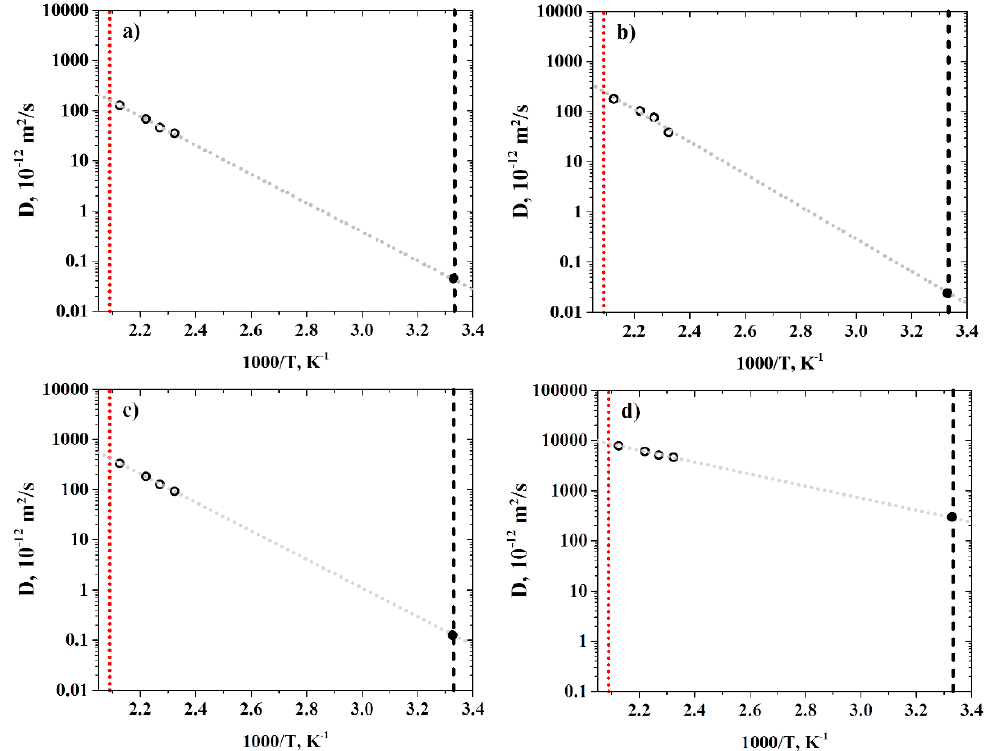
Figure 6. Dependence of the diffusion coefficients of ( a ) CH 4 , ( b ) N 2 , ( c ) O 2 , and ( d ) He in R-BAPB on the reciprocal temperature obtained in molecular dynamics simulations. Semi-logarithmic axes. The red dotted line indicates the glass transition temperature of R-BAPB. The black dashed line corresponds to T = 300 K. The solid black symbols indicate the diffusion coefficients at T = 300 K, obtained by extrapolating the diffusion coefficients at higher temperatures, using the Arrhenius Law. The error bars are of the size of the symbols.